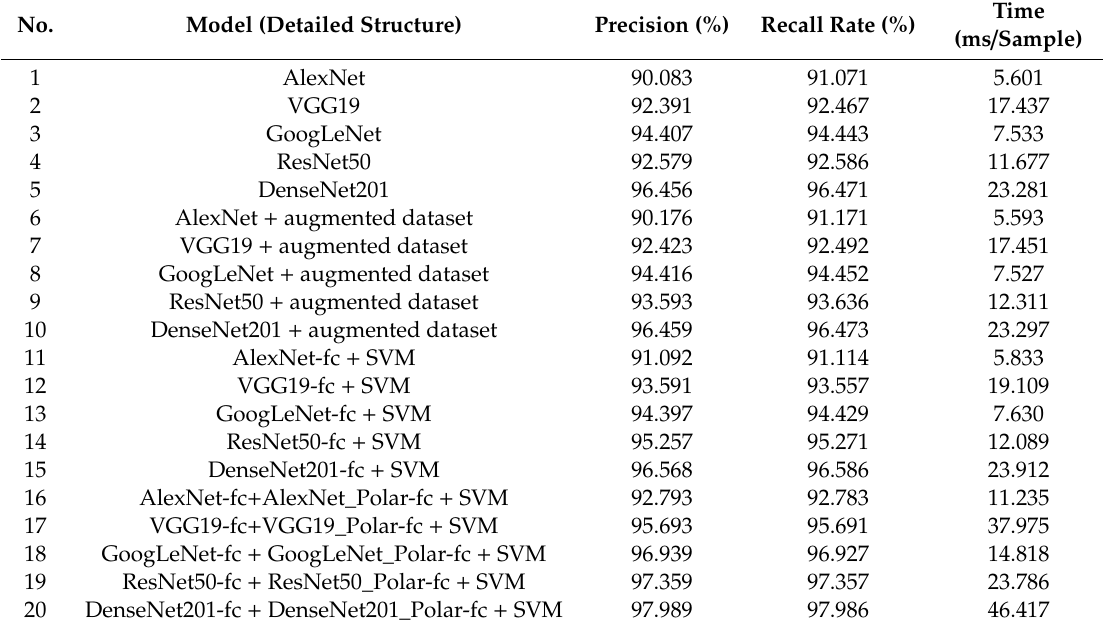
Table 1. Performances of di ff erent models with respect to the dataset constructed in the present study.